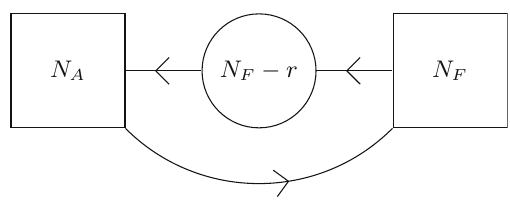
Fig. 3 A single 2d gauge node of rank r with N F fundamental and N A anti-fundamental flavours attached to it